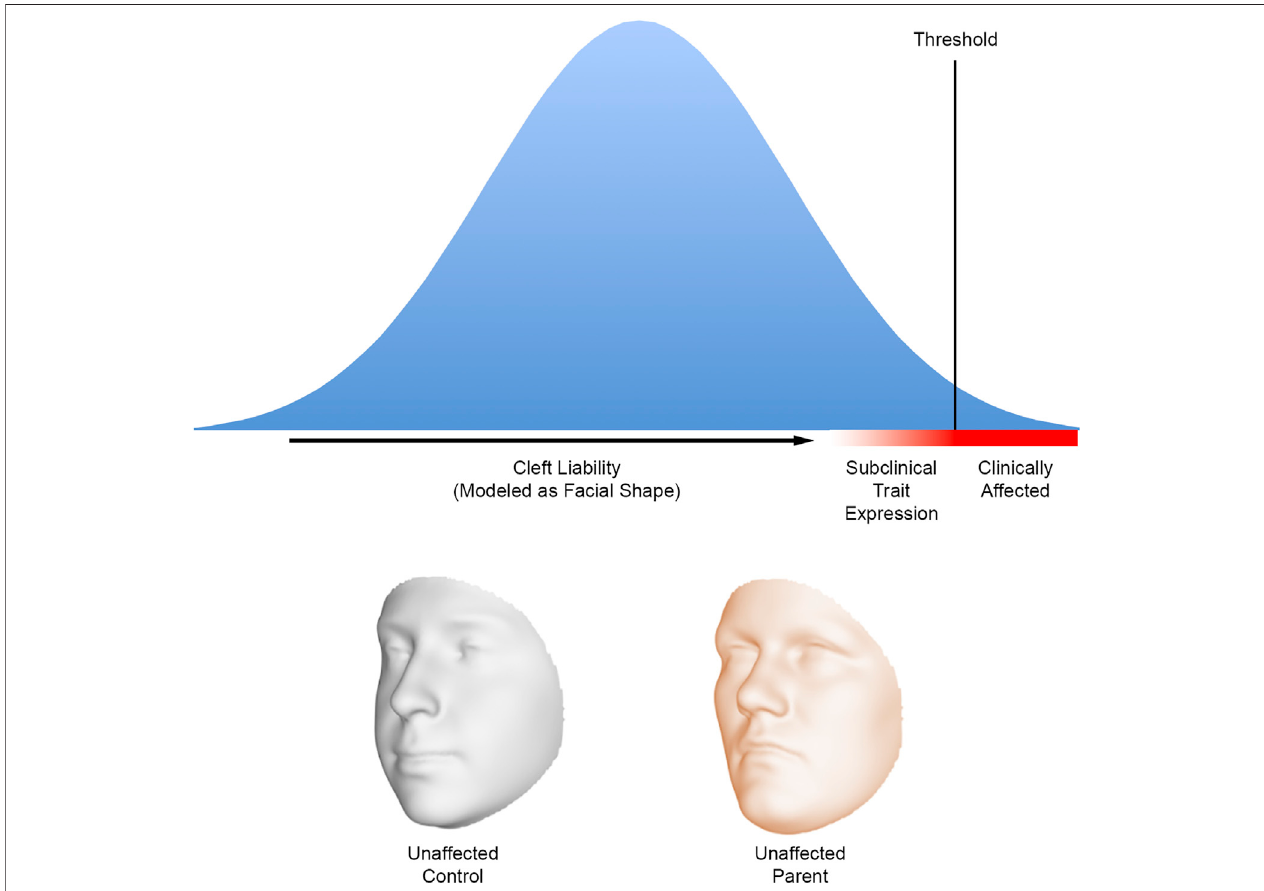
FIGURE 1| Ahypothetical liability threshold model for orofacial clefting where the liability ismodelled asfacialshape. The facial shape ofindividuals near the defect thresholdisexpected todifferon averagefrom thegeneralpopulation;thealtered facial shapecan beconsidered asubclinicalexpression resulting fromthepresenceof cleft risk factors. The biological relatives of those affected with orofacial clefts are expected to be closer to the threshold — and therefore exhibit facial differences — comparedwithanindividualchosenatrandomfromthepopulation.Thefacesbelowthegraphshowhowthe3Dfacialsurfacechangesshapefroma hypotheticalcontroltoahypotheticalunaffectedparentofachildaffectedbynonsyndromicCL/P.These3Dmorphsarebasedonacomparisonof264parentalfacesto 3,171 control faces (Indencleef et al., 2021). Note the relative midfacial fl attening and upper facial broadening in the parental face. Faces adapted from Indencleef et al. (2021), CC BY 4.0.